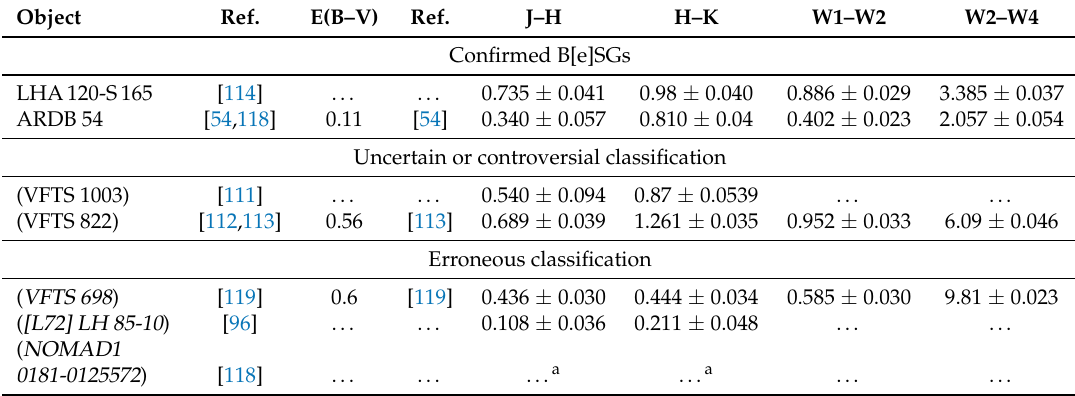
Table 4. Confirmed and candidate B[e]SGs in the LMC. Misclassified objects are listed in the bottom part of the